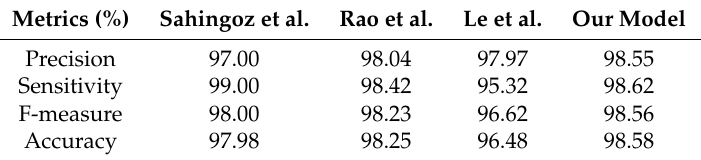
Table 9. Comparison of the proposed model with existing baseline models on